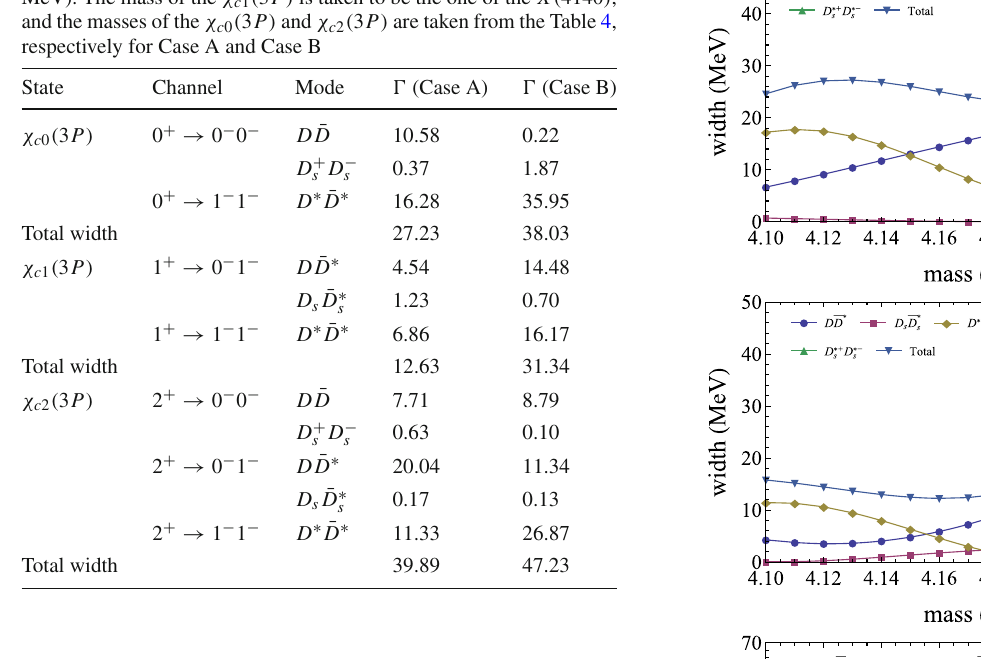
Table 5 Decay widths of the χ c 0 ( 3 P ) , χ c 1 ( 3 P ) and χ c 2 ( 3 P ) states (in MeV). The mass of the χ c 1 ( 3 P ) is taken to be the one of the X ( 4140 ) , and the masses of the χ c 0 ( 3 P ) and χ c 2 ( 3 P ) are taken from the Table 4,